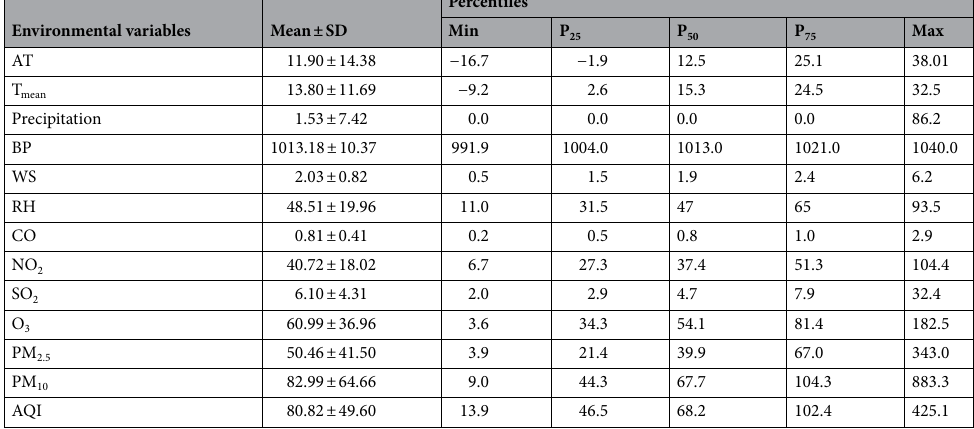
Table 2. Summary statistics of daily meteorological and air pollution data between 1st March 2017 and 28th February 2019. SD, standard deviation; AT, apparent temperature; T mean , daily mean of ambient temperature; BP, barometric pressure; WS, wind speed; RH, relative humidity; CO, carbon monoxide; NO 2 , nitrogen dioxide; SO 2 , sulfur dioxide; O 3 , ozone; PM 2.5 , particulate matter with a diameter less than 2.5 µm; PM 10 , particulate matter with a diameter ≥ 10 µm; AQI, air quality index.